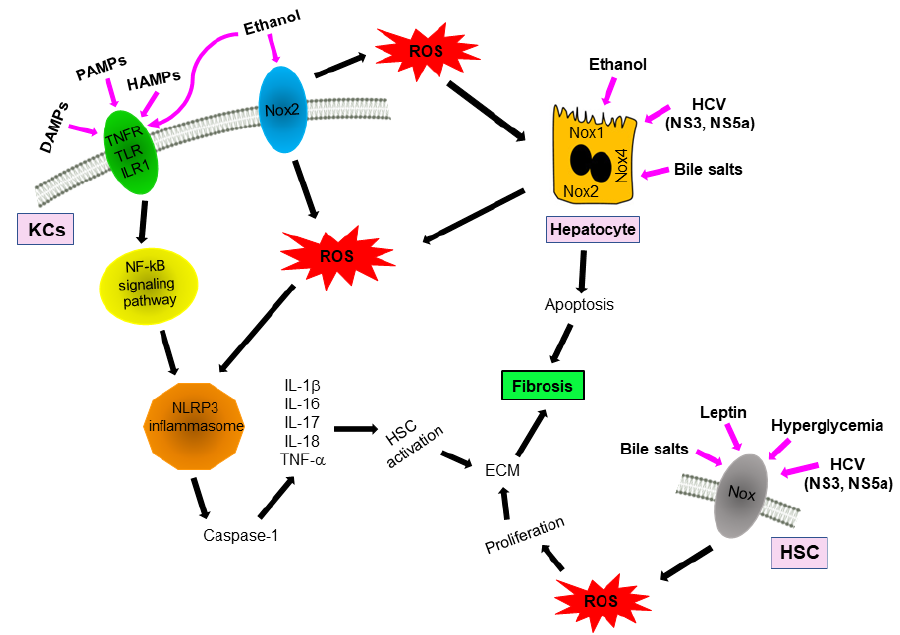
Figure 3. Fibrosis process in the liver with the participation of NOX. Tissue response to damage- causing stimuli is regulated by inflammasomes (NLRP3). NLRP3 are activated by damage-associated molecular patterns (DAMPs), pathogen-associated molecular patterns (PAMPs), or homeostasis- altering molecular processes (HAMPs). Oxidative stress is crucial in this process. KCs and damaged hepatocytes in the liver release a large amount of ROS. Tumor necrosis factor receptor (TNFR), Toll- like receptors (TLR), and IL receptor 1 (ILR1) activation cause signaling of NLRP3 through NF κ B. In KCs, NLRP3 participates in caspase-1 activation. Caspase-1 controls the release of IL-1, IL-16, IL-17, IL-18, and TNF- α . These cytokines cause HSC activation with the deposition of extracellular matrix (ECM) and liver fibrosis. Various stimuli such as ethanol, bile salts, HCV, leptin, and hyperglycemia activate NOX in different liver cells, producing ROS and fibrosis.